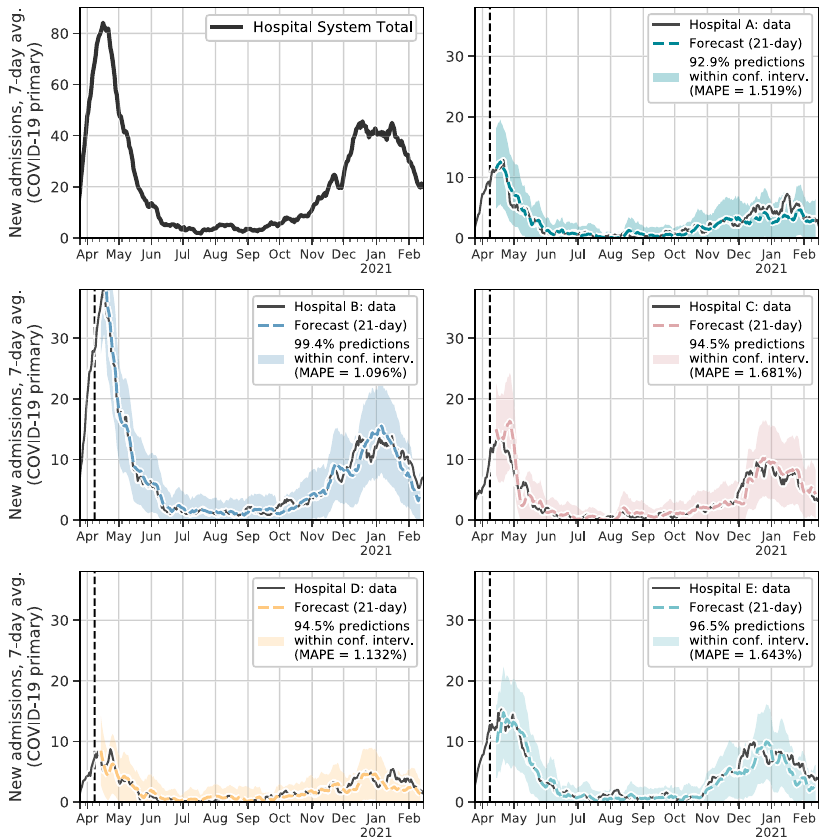
Fig. 2 21-day forecast for each hospital. Top left: total hospitalizations across all fi ve hospitals. Each other subplot compares the actual to the predicted hospital admissions, based on the model that incorporates mobility and test positivity data as exogenous variables. The vertical dashed line marks the boundary of boundary of initial training data and future data; visualized at a 7-day rolling average; 95% con fi dence intervals are shown for each forecast. Hyper-parameters of each model were tuned separately to make sure fair comparisons were made between